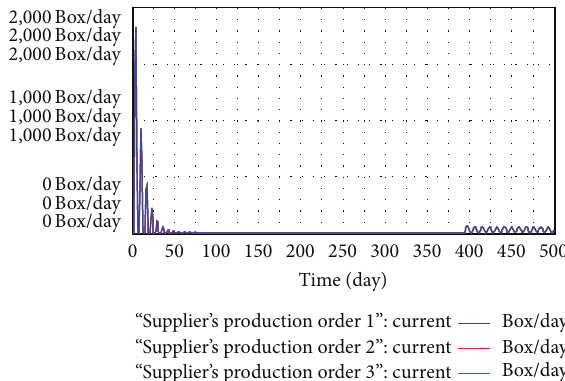
Figure 6: The members’ order quantity changes when recycler reaction coefficient is 1.